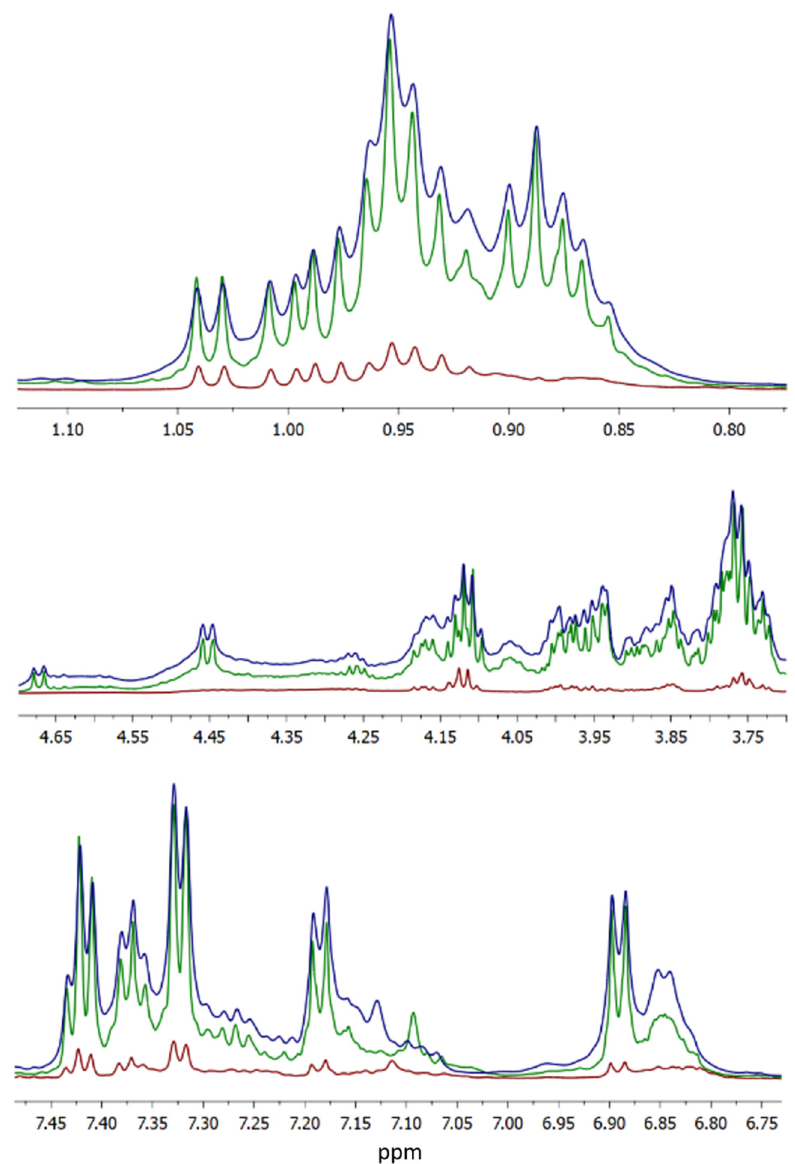
Figure 2. Proton HR-NMR spectrum of PRC digestion fluids at G120 (brown trace), D60 (green), and D120 (blue) phases. The ( top panel ) shows the upfield region, where mainly aliphatic hydrogen atoms of branched side chains of amino acids resonate. The ( middle panel ) shows the midfield spectral region, where hydrogen atoms bound to amino acids alpha-carbon resonate. Finally, the ( bottom panel ) shows the downfield spectral region, where hydrogen atoms belonging to aromatic amino acids resonate.